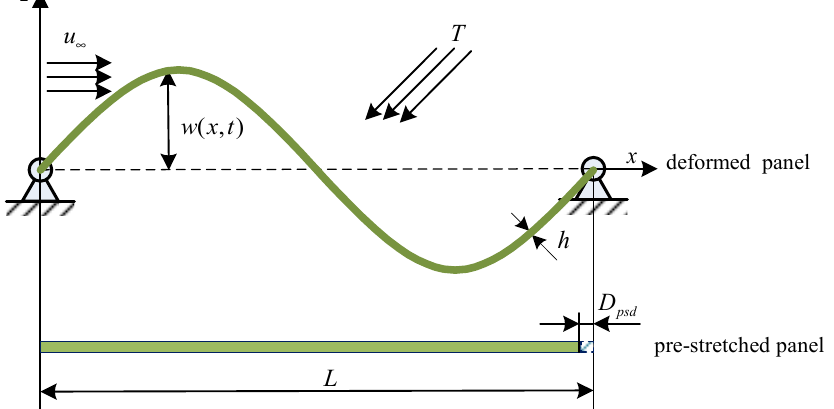
Figure 1. Sketch of a two-dimensional nonlinear heated pre-stretched panel in a supersonic airflow. The pre-stretch displacement produced by stretching the panel is D psd , the chord length after stretching is L , the thickness is h , the span is b = 1, and the density is ρ . The upper surface of the panel is subject to a supersonic airflow along the x-direction with density ρ ∞ , speed u ∞ , and Mach number M ∞ . ∆ T is the temperature elevation, and the reference temperature is T ref , ∆ T = T − T ref